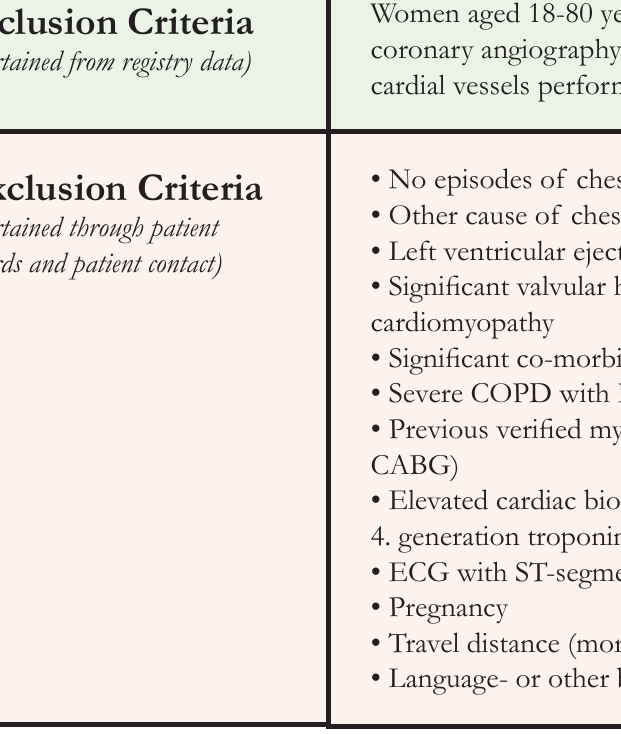
Fig 1. Inclusion and exclusion criteria in the iPOWER